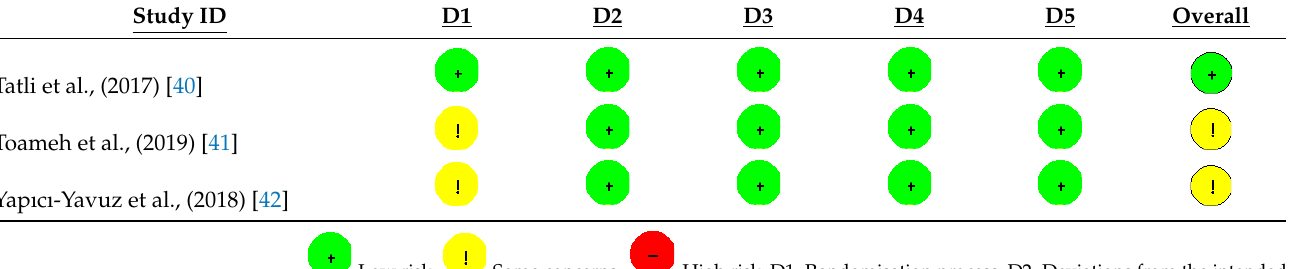
Table 2. Risk of bias assessment .